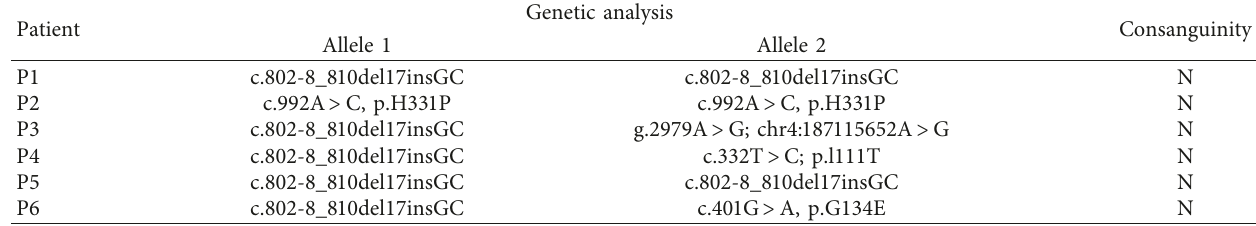
Table 1: Genetic and consanguinity status.